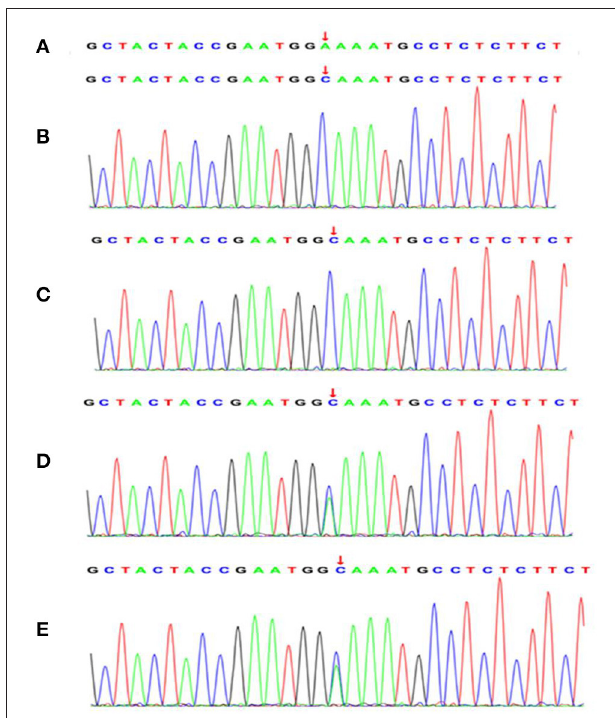
FIGURE 2 | A novel missense mutation in exon 5 (A593C) of the NPHS2 gene was identified by Trio whole-exome sequencing in the affected individuals and family members. (A) normal control sequence. The affected elder sister (B) and the affected younger brother (C) carried the homozygous missense mutation in exon 5 (A593C) of the NPHS2 gene. The father (D) and the mother (E) of the affected patients revealed the heterozygous missense mutation in exon 5 (A593C) of the NPHS2 gene. The arrows indicate mutant